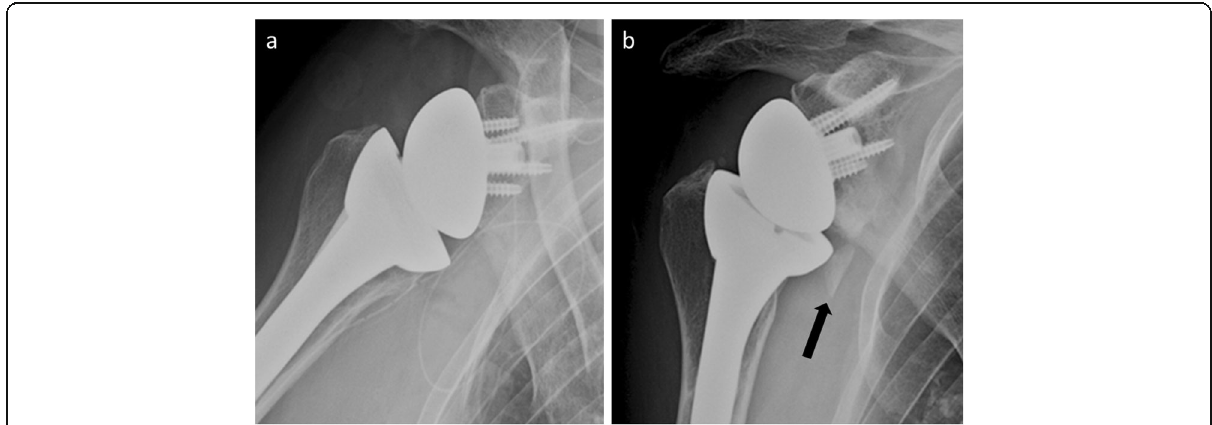
Fig. 9 Anteroposterior shoulder radiographs of an 84-year-old woman with reverse shoulder arthroplasty. a Normal postoperative radiograph. b One year later, radiograph shows heterotopic ossification (arrow), with the patient